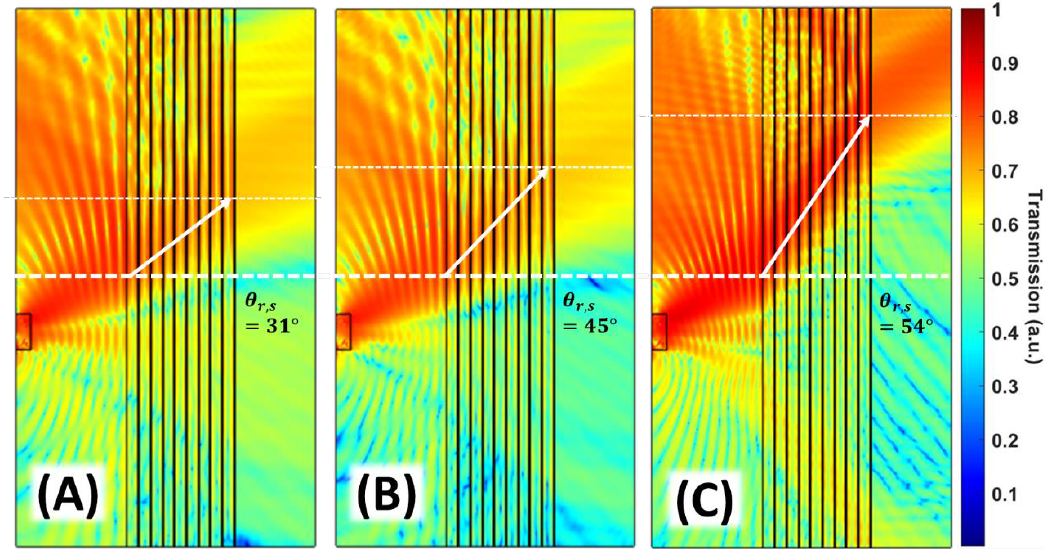
Figure 2. Numerical simulation of refraction of monochromatic beams incident to the 10 layers superlattice structure at 10° angle. Different refraction angles are observed for ( A ) 95 kHz, ( B ) 105 kHz, and ( C ) 115 kHz. The acoustic pressure distribution maps showed in normalized linear scale. 𝜃 𝑟 refers to refraction angle. Subindex s was indicated simulation results.